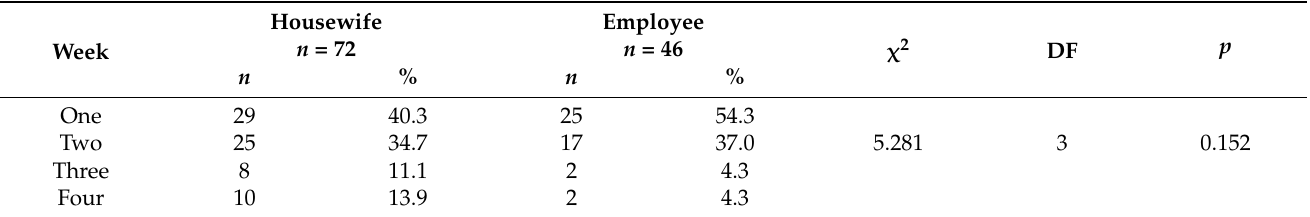
Table 5. Responses to the question: “When did you notice the positive correction of the cleft segments?” in association with working status.